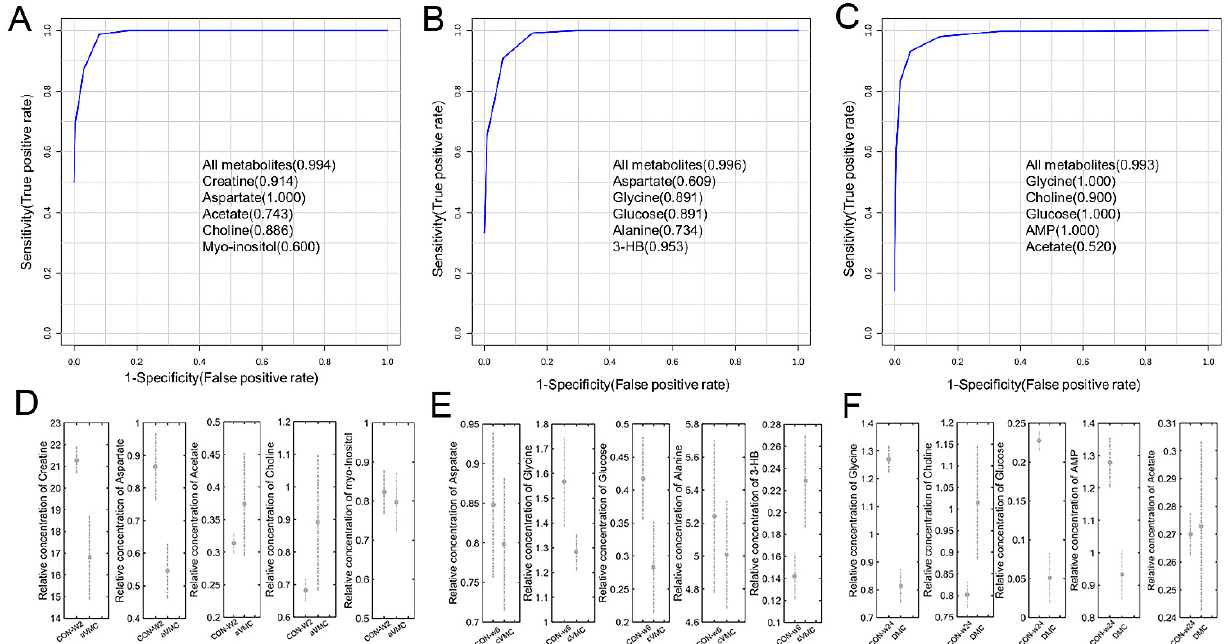
Figure 2. Multivariate ROC analyses of cardiac tissues for identifying potential biomarkers in the three pathological stages and comparisons of relative levels of potential identified biomarkers: ( A – C ) multivariate ROC analyses of aVMC vs. CON-w2 ( A ); cVMC vs. CON-w6 ( B ); DCM vs. CON- w24 ( C ); ( D – F ) comparisons of relative levels of potential biomarkers for aVMC vs. CON-w2 ( D ); cVMC vs. CON-w6 ( E ); DMC vs. CON-w24 ( F ).